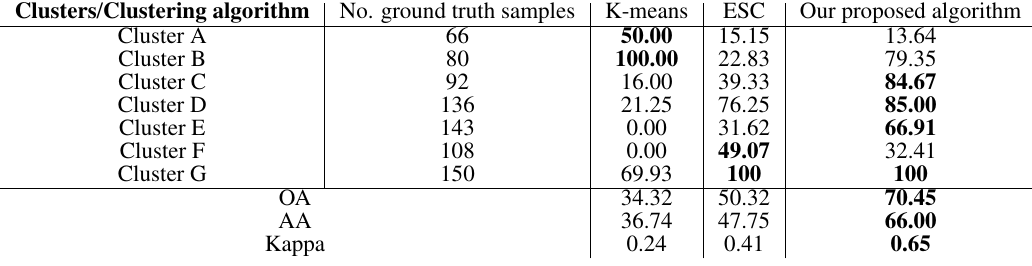
Table 1. Quantitative assessment on the performances of the clustering algorithms applied to Scene No.1. The clustering performance is evaluated using overall accuracy (OA), average accuracy (AA), and Kappa coefficient.